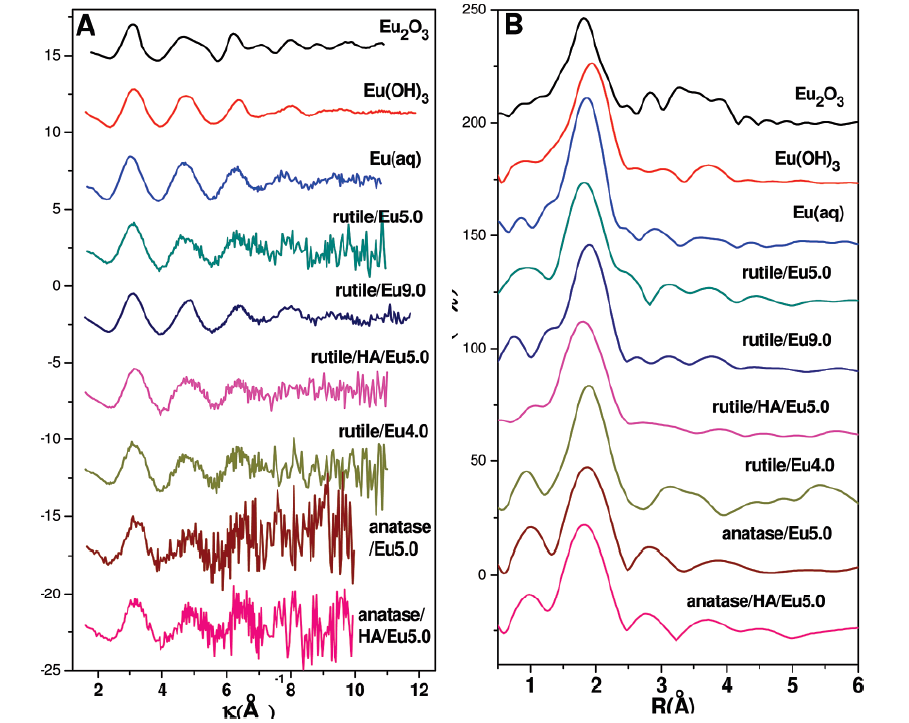
Figure 14. k 2 -weighted EXAFS spectra (A) and the corresponding Fourier transforms (B) of reference samples and sorption samples. Eu(III) adsorbed on rutile at pH 5.0 (rutile/Eu5.0), at pH 4.0 (rutile/Eu4.0) and at pH 9.0 (rutile/Eu9.0). The presence of HA at pH 5.0 (rutile/HA/Eu5.0 and anatase/HA/Eu5.0). Eu(III) adsorbed on anatase at pH 5.0 ) = 0.3 g/L, C(Eu(III)) = 3.0 × 10 -5 mol/L, (anatase/Eu5.0). C(TiO 2 (initial) ) = 0.01 mol/L, C(HA) = 7.5 mg/L, pH = 4.0 ± 0.1 or 5.0 ± 1, C(NaClO 4 (initial) T = 25 ± 1 o C